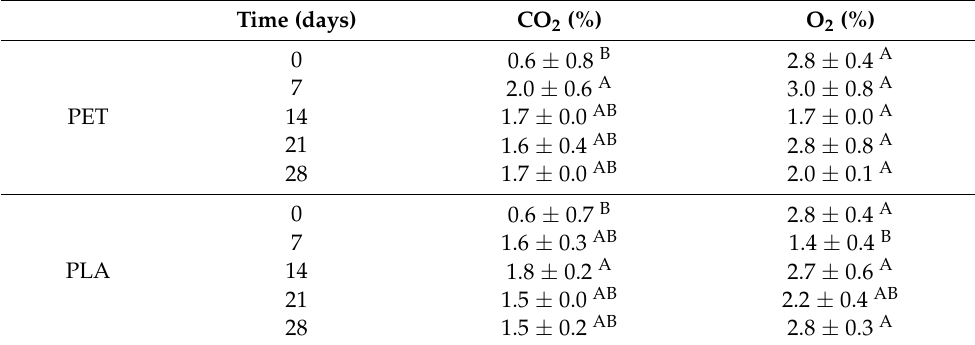
Table 2. Percent gas composition of the headspace of PET and PLA apple juice bottles. Values are presented as mean ± standard